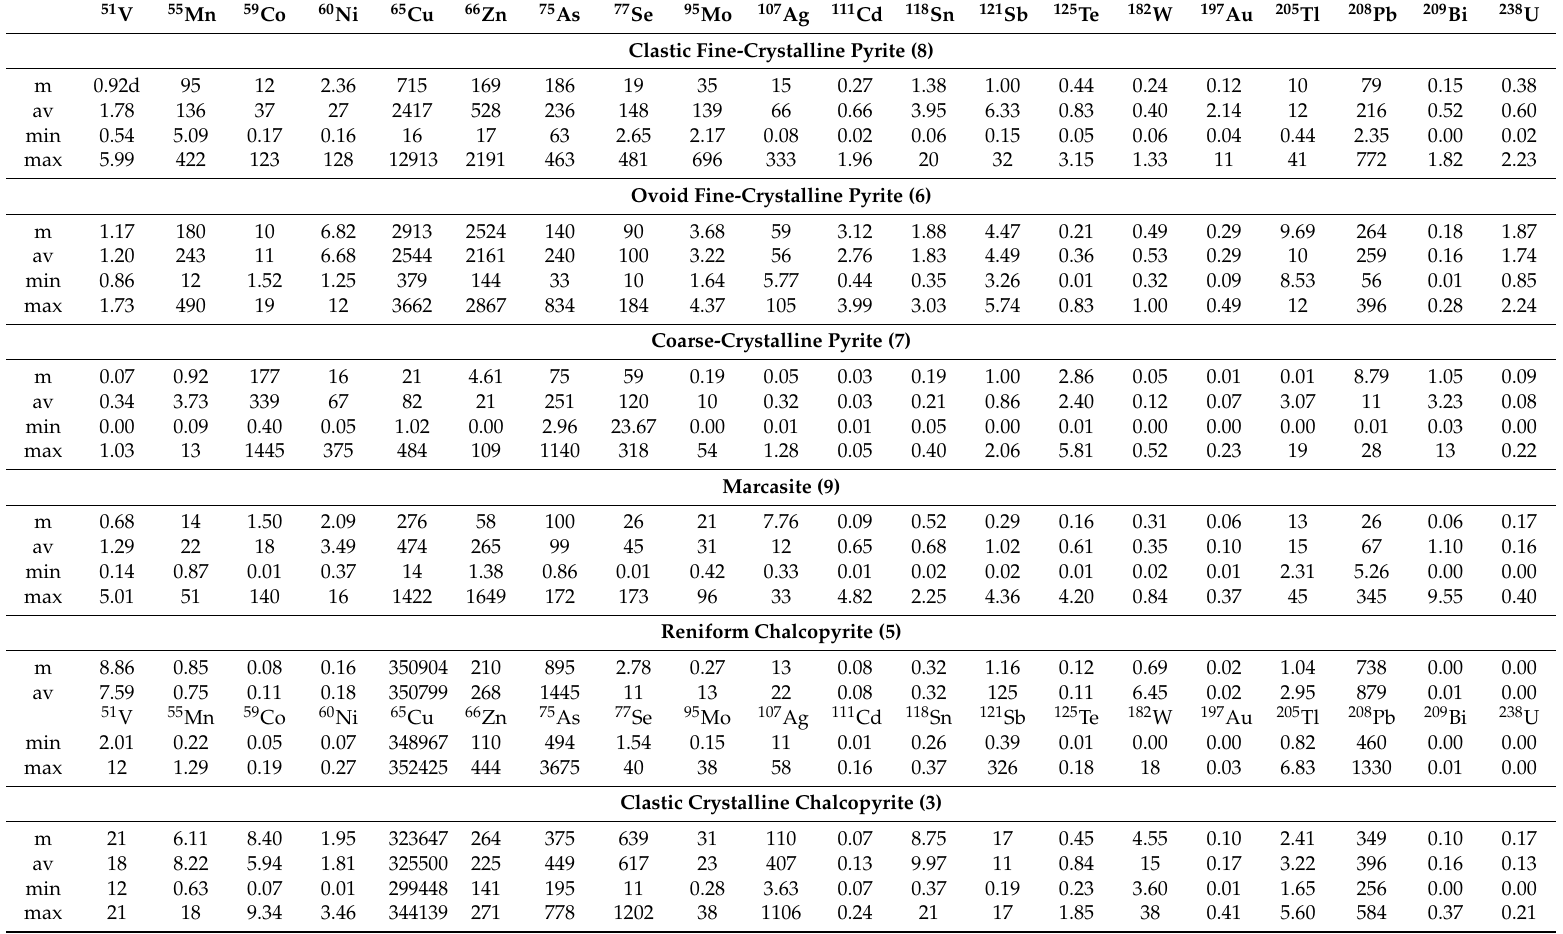
Table 5. Trace element composition of sulfides from the Semenov-3 hydrothermal field